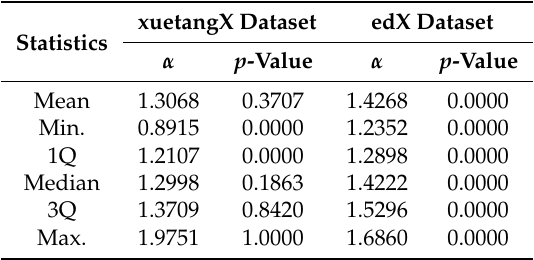
Table 1. Statistics of α and p -value of the two